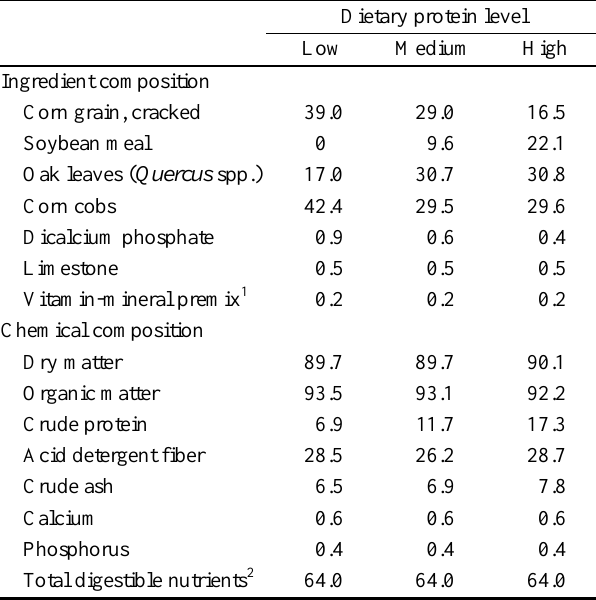
Table 1. Ingredient and chemical composition (%, DM basis) of diets with different levels (approximately 7%, 12%, and 17%) of crude protein fed to female spotted deer Dietary protein level Low Medium Ingredient composition